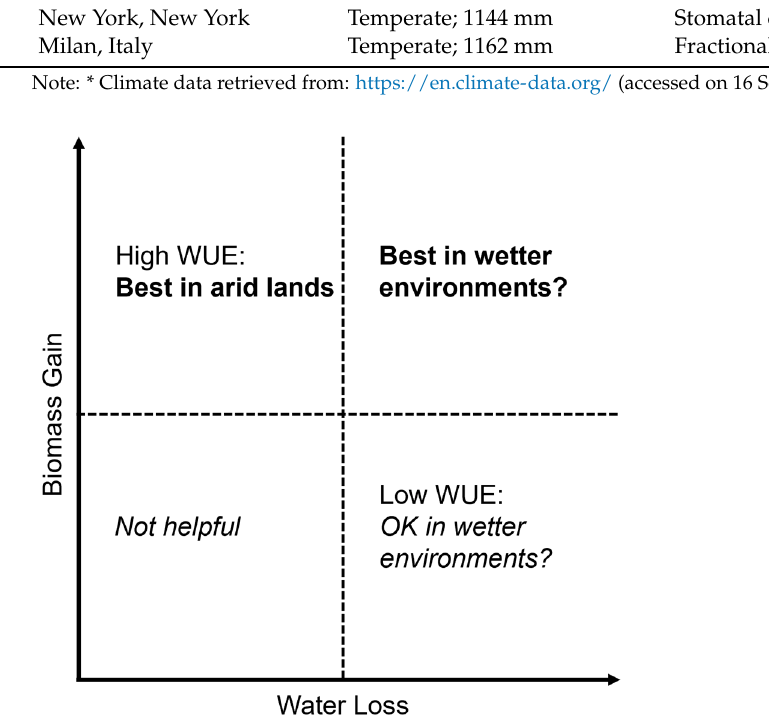
Figure 1. A conceptual relationship between biomass gain (i.e., greenness) and water loss (i.e., stomatal conductance) displaying suitability of WUE for urban stormwater management.